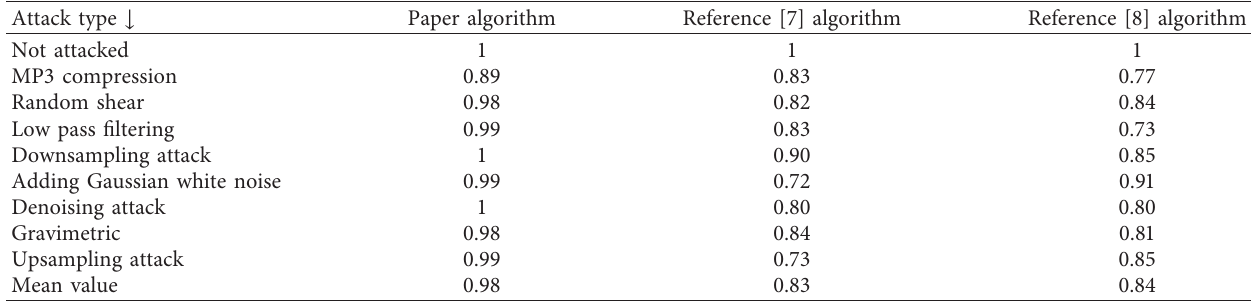
Table 4: Test results of resistance to